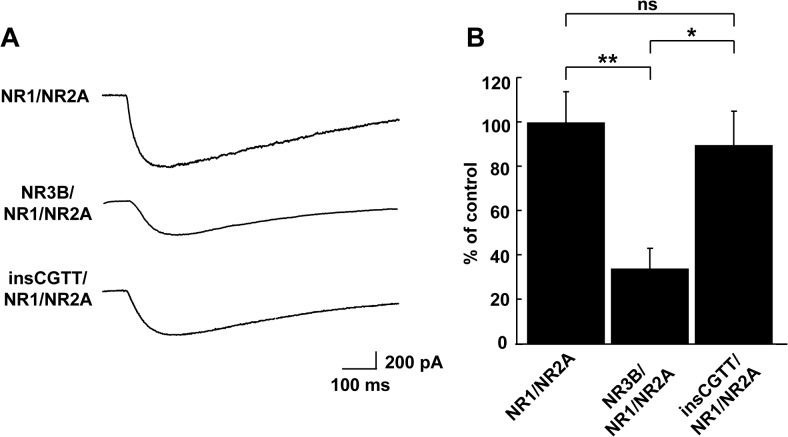
Glutamate-induced whole-cell current recorded from HEK293T cells expressing major type or insCGTT type NR3B.
A, Sample traces of glutamate-induced whole-cell current recorded in HEK293T cells coexpressing NR1 and NR2A with or without NR3B major type or insCGTT type. The recordings were performed at -60 mV in the presence of 10 μM glycine and in the absence of Mg2+. B, The normalized current amplitude from cells without NR3B, with NR3B major type or insCGTT type. The major type NR3B suppressed the current to a statistically significant level, whereas insCGTT type did not show such suppression. The time course of current decay reflects the clearance of puffed glutamate from extracellular fluid by perfusion rather than the kinetics of channel opening and closing. n = 14, each. **: p<0.01 from control, *: p<0.05 from major type, ns: not significant.